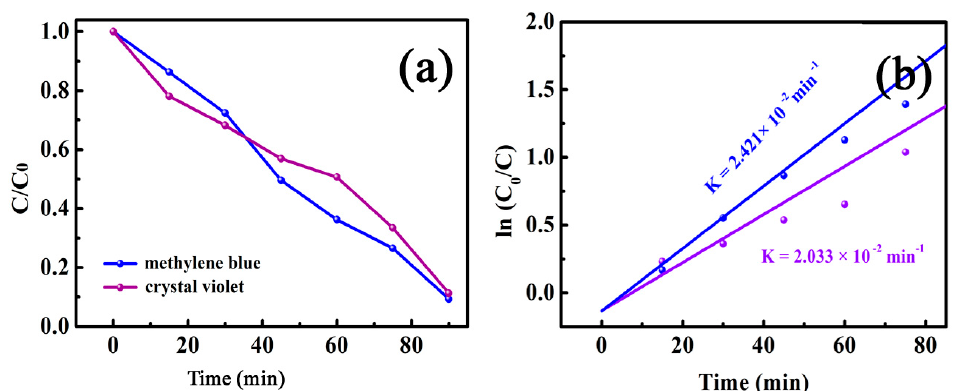
Figure 11. ( a ) The photo ‐ Fenton degradation and ( b ) corresponding pseudo first ‐ order kinetic curves of crystal violet and methylene blue solutions on MnFe 2 O 4 /BGA − 1.3 in the presence of H 2 O 2 under visible light (catalyst dose: 2 mg, volume of 30% H 2 O 2 : 1.0 mL, [dye]: 10 mg/L, volume of dye solution: 50 mL).